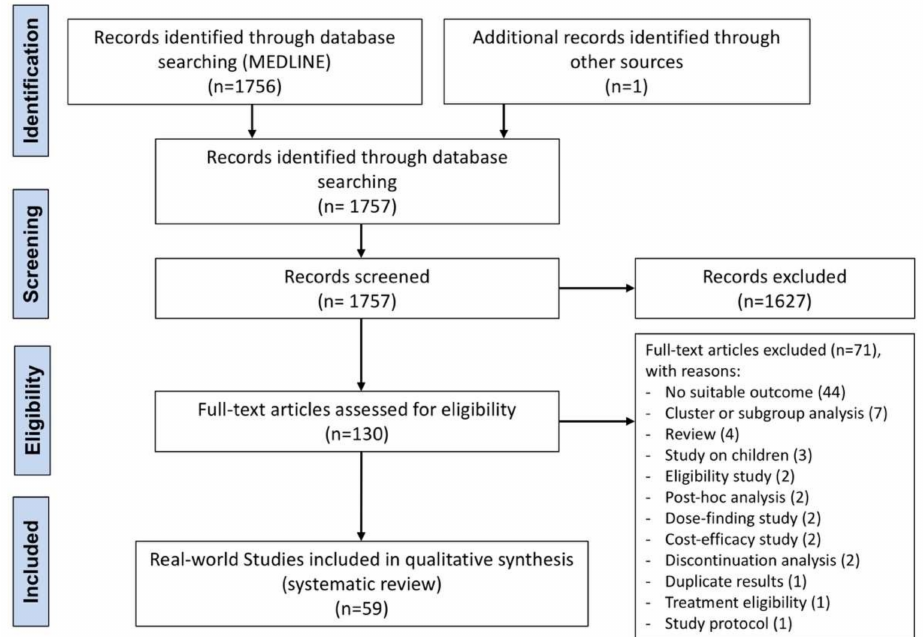
Figure 1. PRISMA flow diagram for the identification of the studies included in the systematic review. PRISMA, Preferred Reporting Items for Systematic Review and